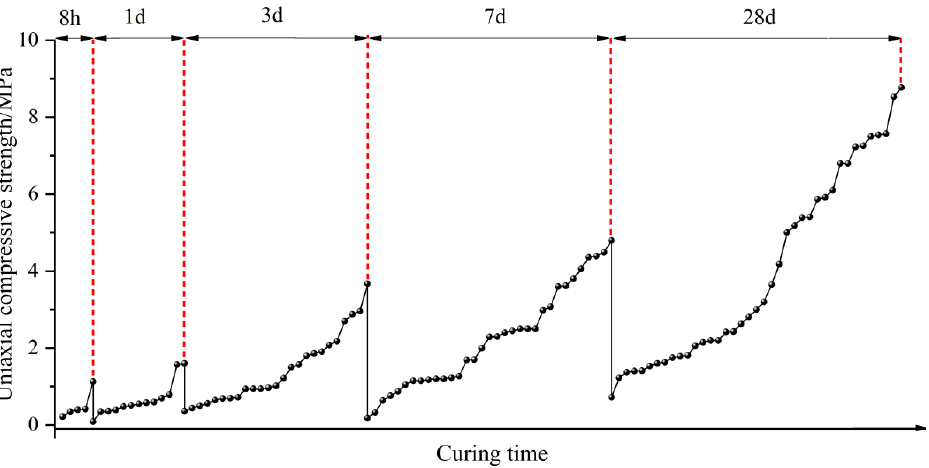
Figure 18. Strength of cemented backfill at different curing ages.